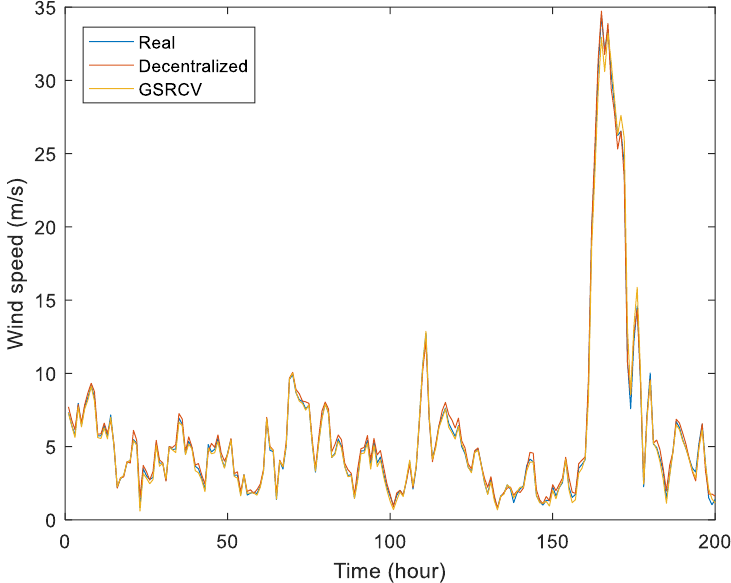
Figure 8. Predictions of different parameter optimization strategies.